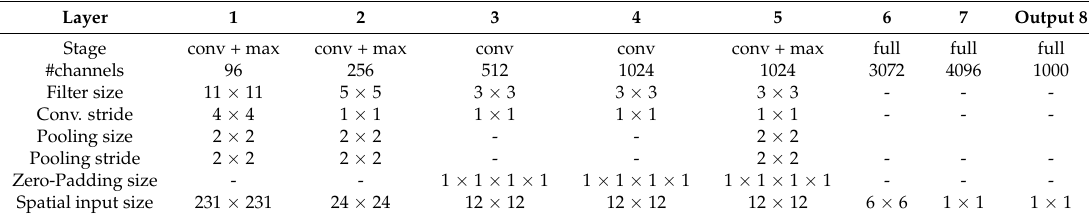
Table 1. Architecture of the OverFeat